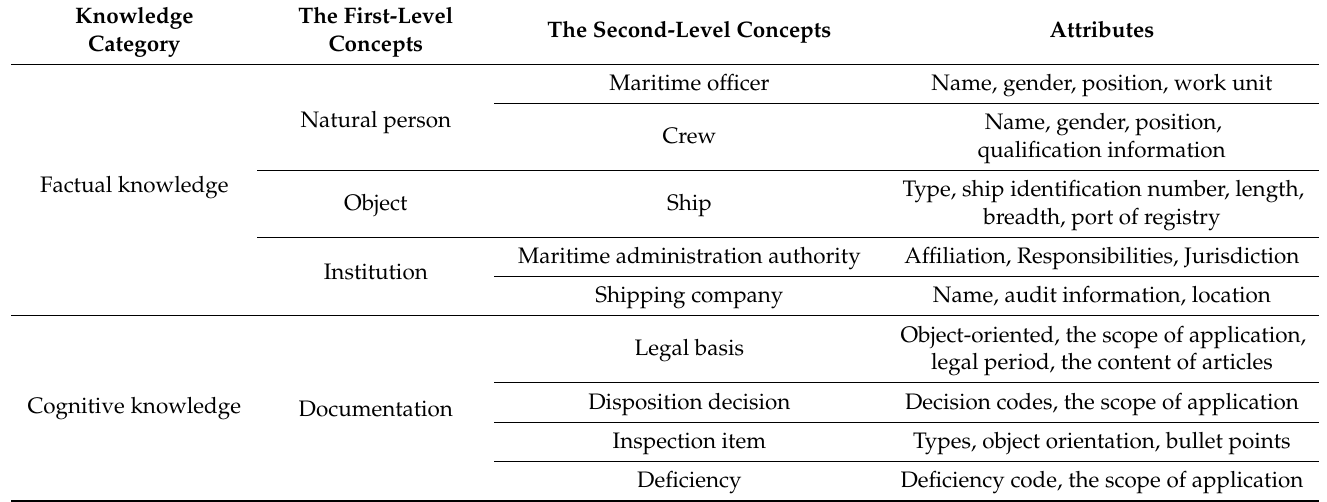
Table 1. FSC inspection knowledge concepts and attributes.